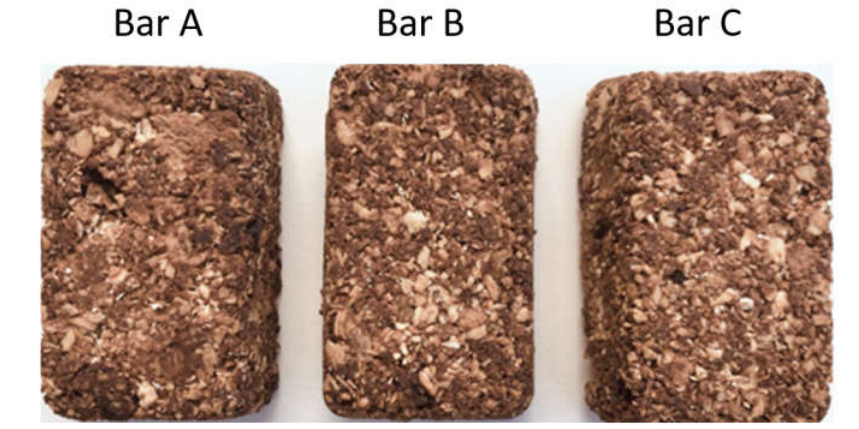
Figure 2. Three visually indistinguishable, nutritionally equivalent ‘muesli’ bars with differing gluten and fructan contents used for a functional dyspepsia randomized, double-blind crossover trial.